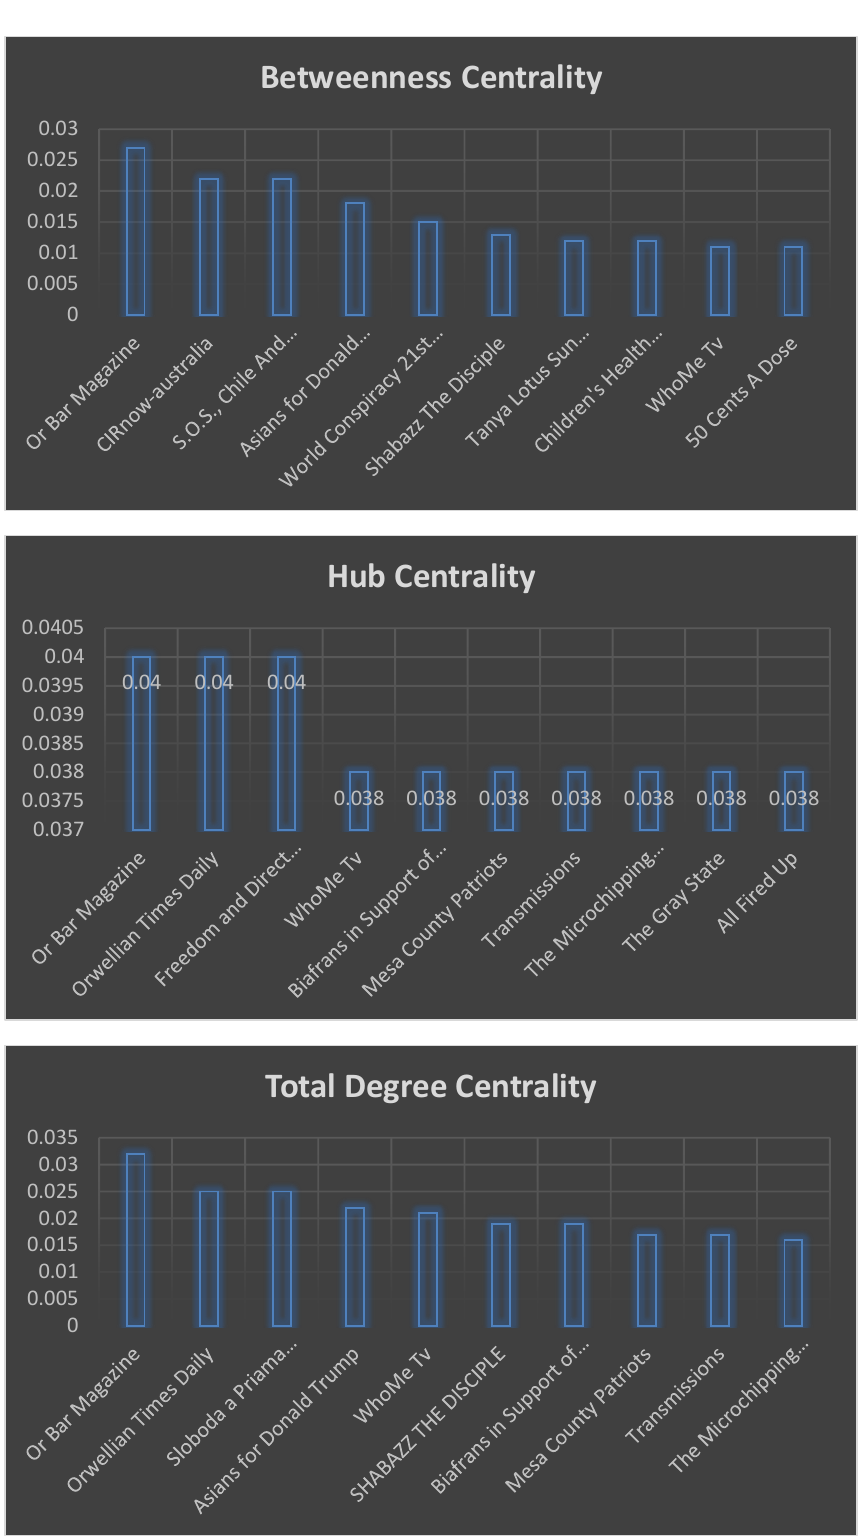
Figure 4. Top ten accounts in terms of betweenness centrality, hub centrality, and total degree